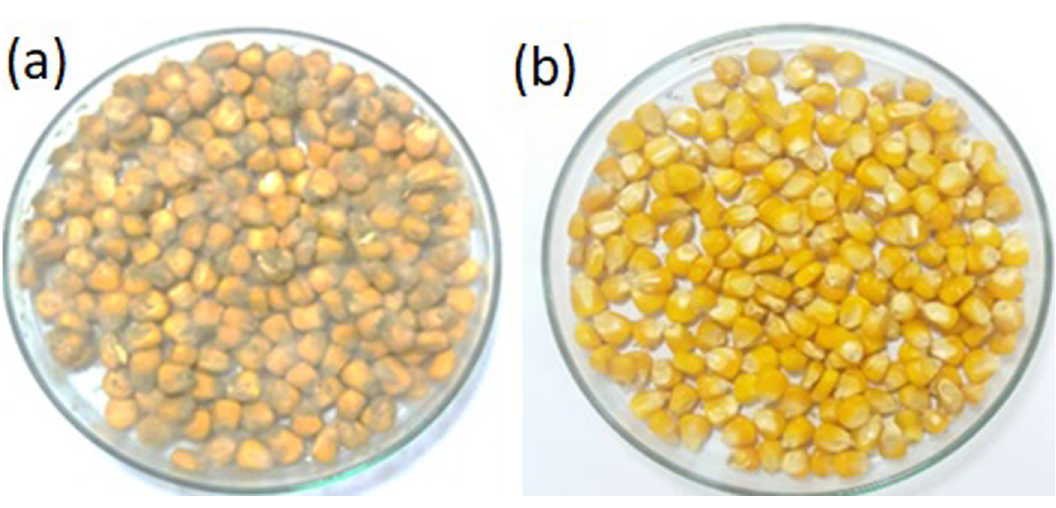
The FT-IR spectra of T1 (untreated maize grains), T2 (MRS broth + A . flavus treated maize grains), and T3 (CFS + A . flavus treated maize grains) were interpreted within the spectral region of 4000–400 cm − 1 . The absorption bands that appeared in the range of 3500–3000